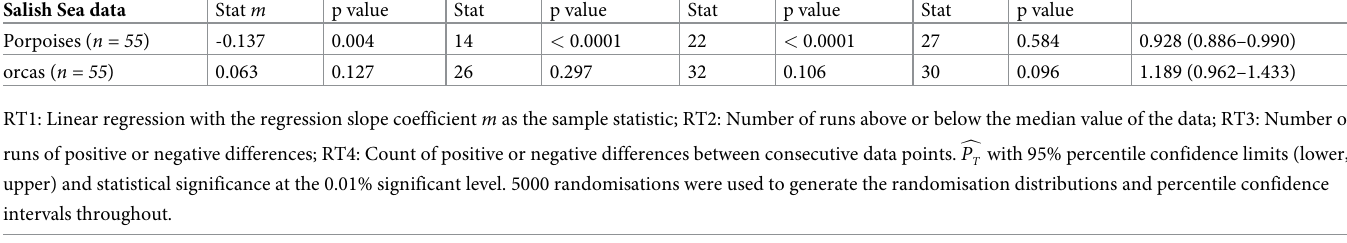
Table 2. Comparison of PYRA trend statistic c P